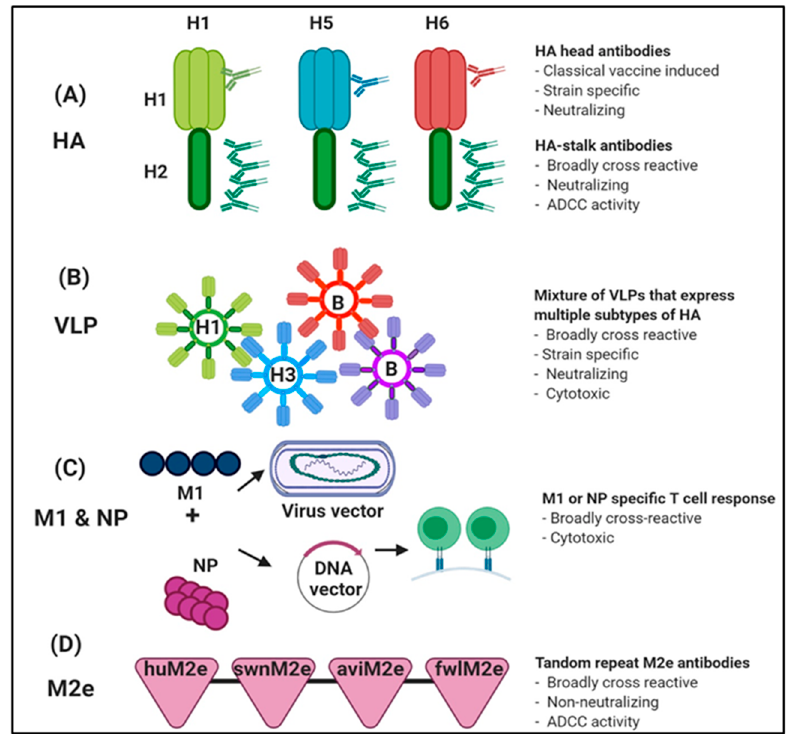
Figure 4. Universal IAV vaccination approaches. ( A ) Chimeric hemagglutinins (cHAs) consist of the exotic globular head domains and the conserved H2 stalk domain. ( B ) Mixture of virus like particles (VLPs) that express multiple subtypes of HA ( C ) Combination approaches with Matrix protein 1 (M1) and nucleoprotein (NP) with virus vectors or DNA vectors. ( D ) Vaccination strategies based on conserved M2 ectodomain (M2e).